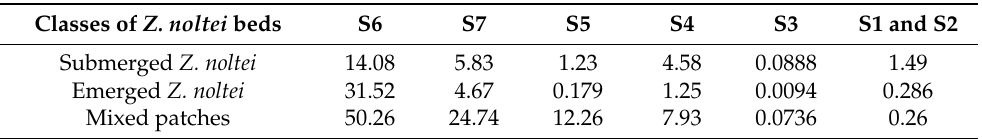
Table 5. The surface areas in ha estimated for Z. noltei meadows for each station in the Merja